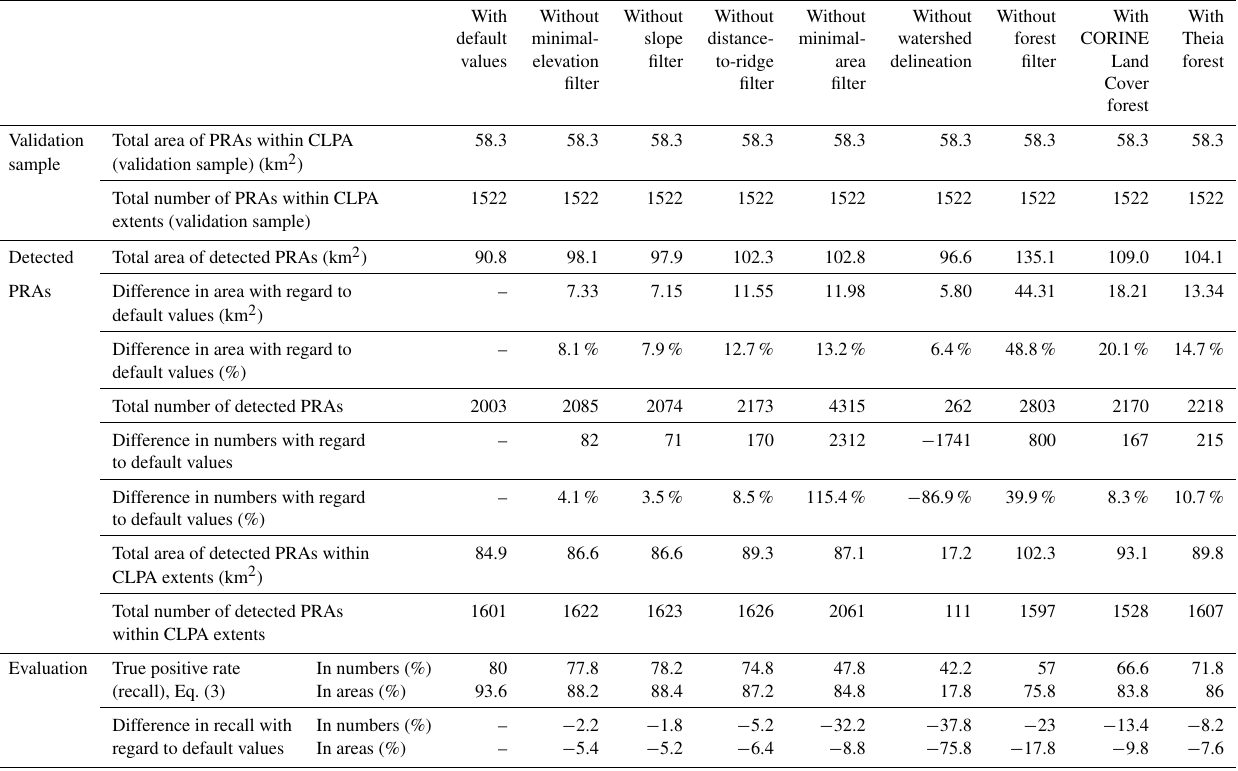
Table 5. Marginal effect on true positive rates of the different factors and data sources, Mont Blanc massif. Total area of detected PRAs and total number of detected PRAs are those of the part of the massif covered by CLPA (Table 1). For the PRA detection, in each column, only the considered factor is removed/varies according to the column label. All other factors and the DEM resolution are set to their default values (Fig. 3). For the determination of the validation sample, all factors and DEM resolution are set to their default values (Fig. 4) and forest cover data are from DB forest